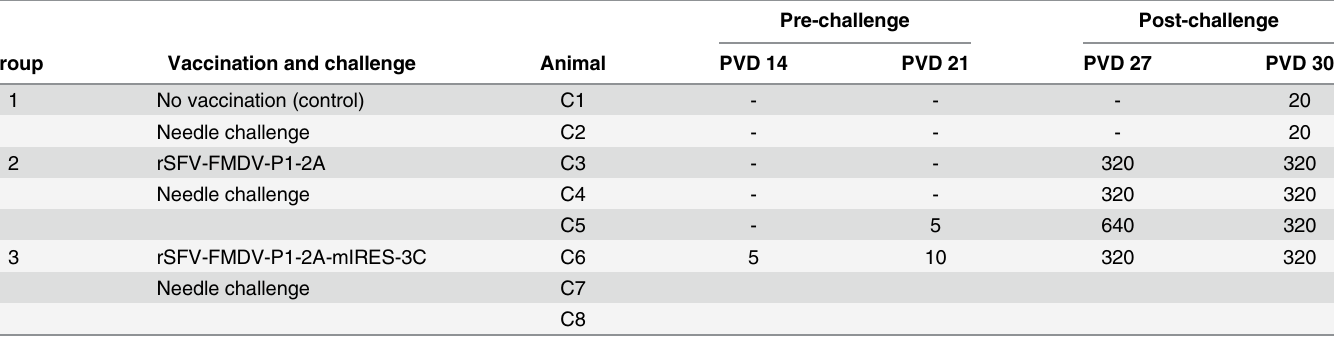
Calves C3 to C8 were vaccinated with the indicated rSFV-FMDV on PVD 0 and then challenged with FMDV by needle inoculation on PVD 21. To determine the titre, sera collected from calves on PVD 14, 21, 27 and 30 were assayed in the ELISA using 2-fold dilutions starting at 1:5. — indicates